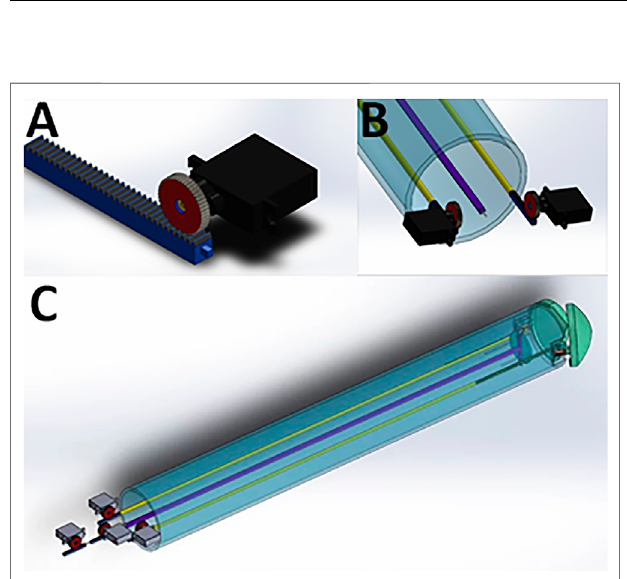
FIGURE 6 | Mounting of micro-servo motors onto the rods of the instrument using the Claw design as an example. (A) One micro-servo motor unit attached to a rod. (B) The proximal (tail end) ofthe instrument showing two micro-servo motor units. (C) View of the whole instrument, showing four micro-servo motor units and the rods connecting the proximal tothe distal